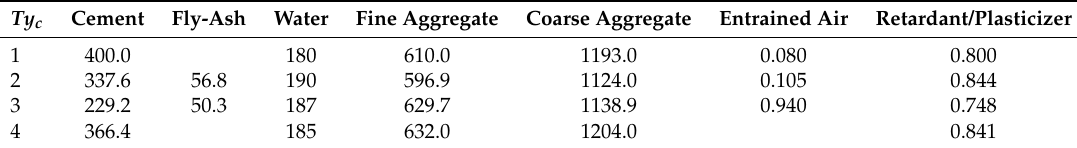
Table 1. Concrete composition in kg/m 3